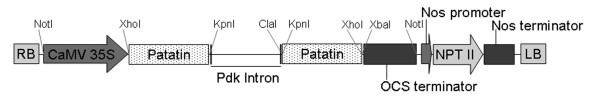
Map of patatin-hpRNAi binary vector. A single PCR product (nucleotides 188–798) from the target gene pat3-k1 was cloned into pKANNIBAL vector in an inverted-repeat orientation (sense-oriented copies in XhoI – KpnI site; anti-sense oriented copies in ClaI – XbaI site). pKANNIBAL vector was digested with NotI enzyme and then NotI fragments were cloned into pART27 binary vector.